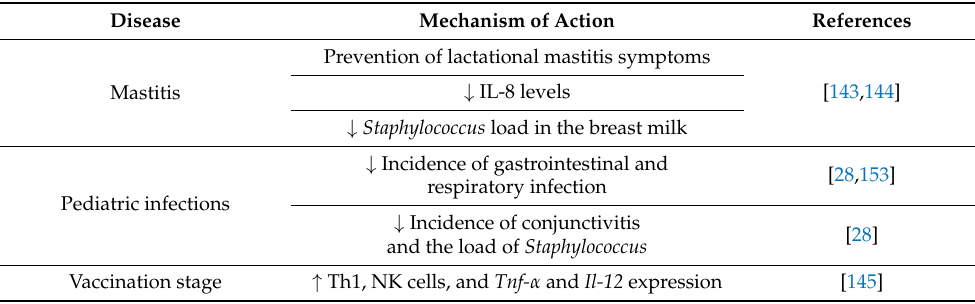
Table 5. Clinical studies: mechanisms of action of Limosilactobacillus fermentum